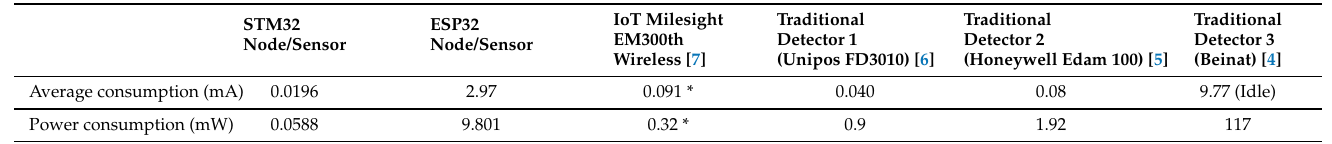
Table 7. Comparison of power consumption between conventional detectors and designs. * Values calculated from official technical